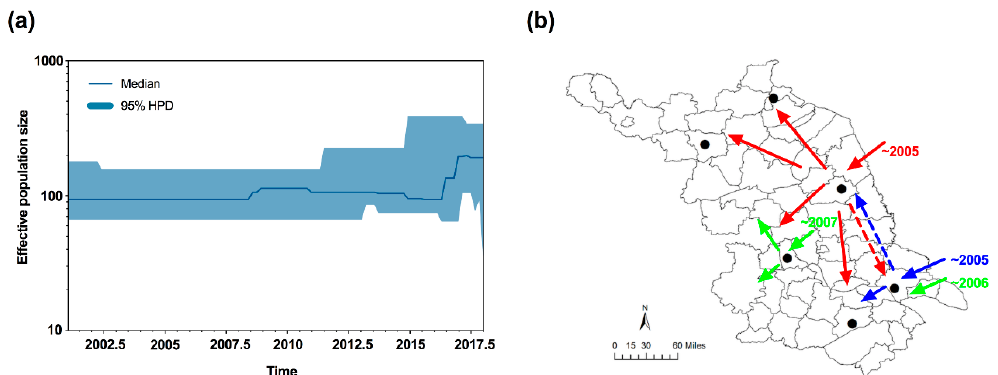
Figure 4. Bayesian skyline plots and inferred invasive routes of B. tabaci MED in Jiangsu. ( a ) Bayesian skyline plots of B. tabaci populations in Jiangsu. The middle lines represent the median estimates of the effective population size, and the shaded areas represent 95% Highest Posterior Densities (95% HPD). ( b ) Inferred invasive routes of B. tabaci . Red and blue arrows indicate the initial invasion routes. Green arrows showed the secondary and/or subsequent invasive events. Dotted lines represented the potential mixing of whiteflies between Nantong and Yancheng. The map of Jiangsu was created using Esri’s ArcGIS platform (http://www.esri.com/software/arcgis).